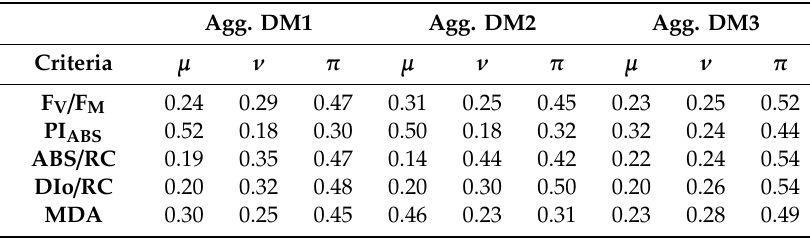
Table 9. Aggregated IF decision matrices for criteria of cold subcategories.